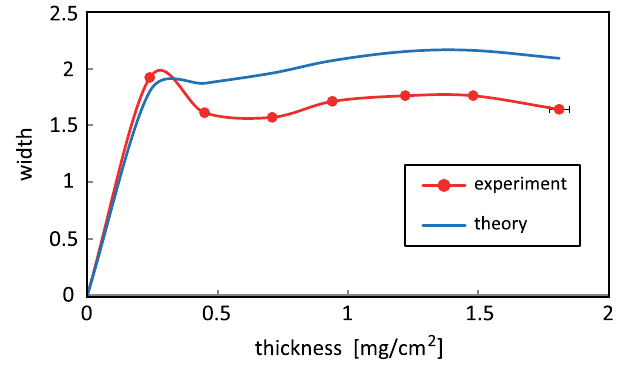
FIG. 9. Dependence of the charge-state distribution width w q on the target thickness.